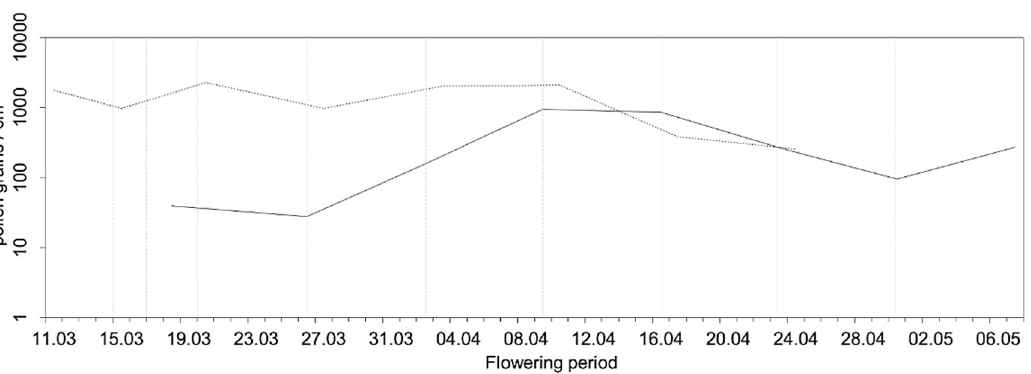
Figure 7. Weekly pollen catch (pollen grains/cm 2 ) presented with a logarithmic scale on the y -axis for horizontal and vertical slides attached at four pollen traps for at the location Emmendingen in 2019 (solid black line) and 2020 (dashed black line).